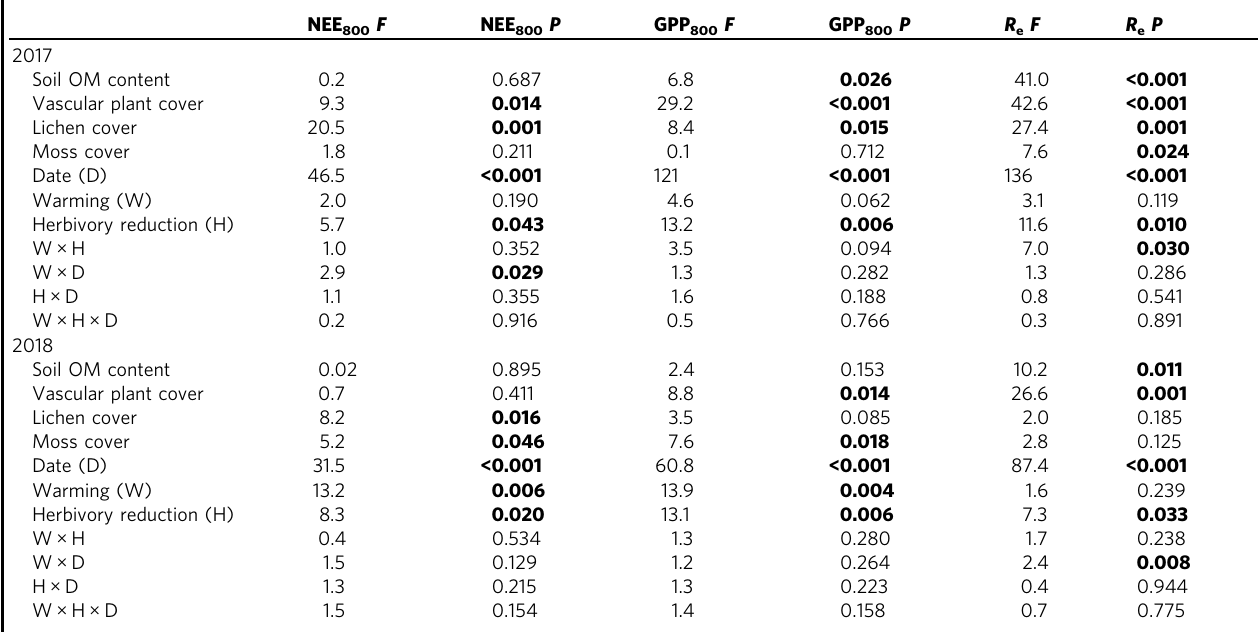
Table 2 Statistics of warming and herbivory effects on NEE 800 , GPP 800 , and R e in 2017 – 2018.